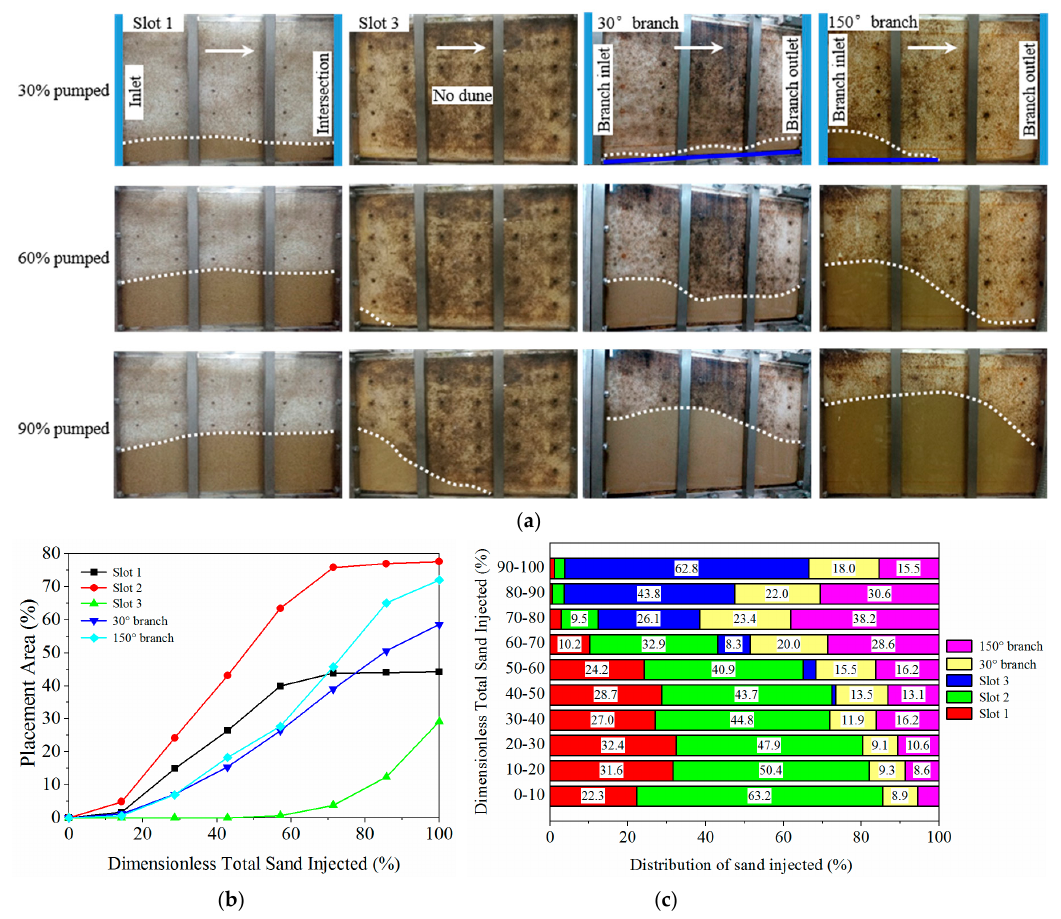
Figure 7. Evolvement of dunes in a slot system with 30°–150°-branches, ( a ) dune geometries in slot 1, slot 3 and branches when 30%, 60%, or 90% of sand were pumped, ( b ) placement areas in the primary and secondary slots, ( c ) distribution of sand injected in the primary and secondary slots.